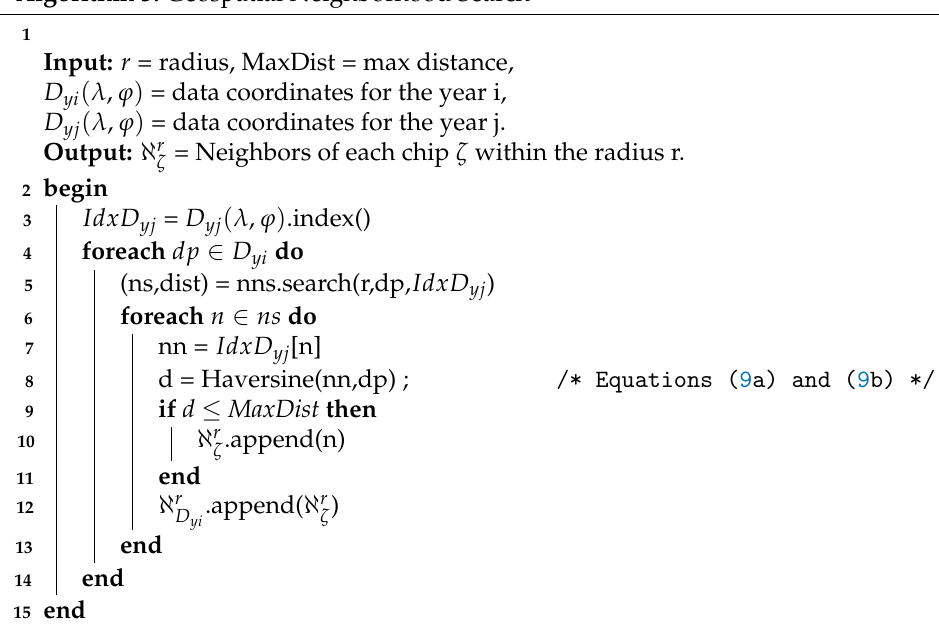
Algorithm 3: Geospatial Neighborhood